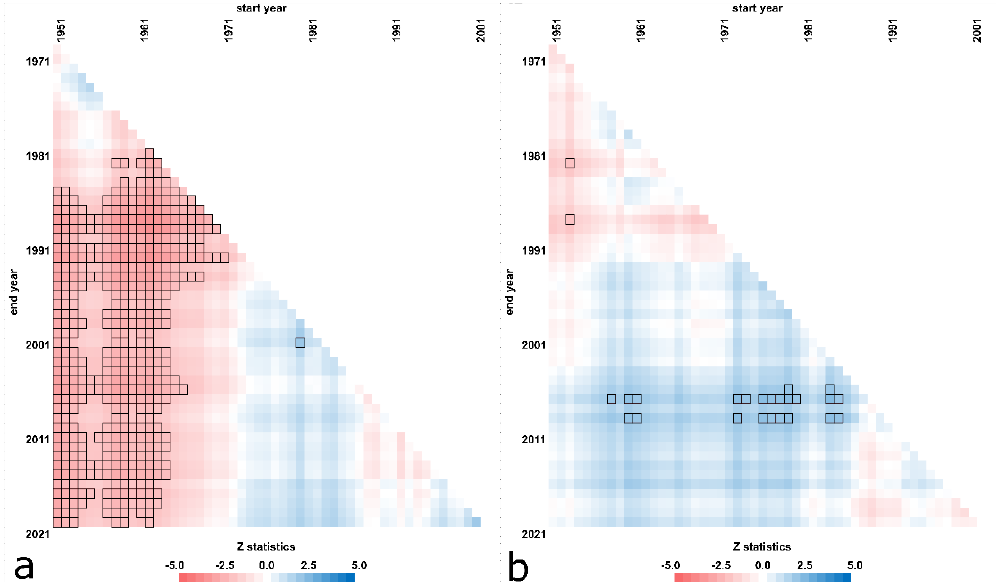
Figure 12. Multitemporal trend analysis of the time of flows between Q50 and Q90% (TQ5090%) for the Gwda ( a ) and Flinta ( b ) rivers (marked fields indicate statistically significant changes at the level 0.05).